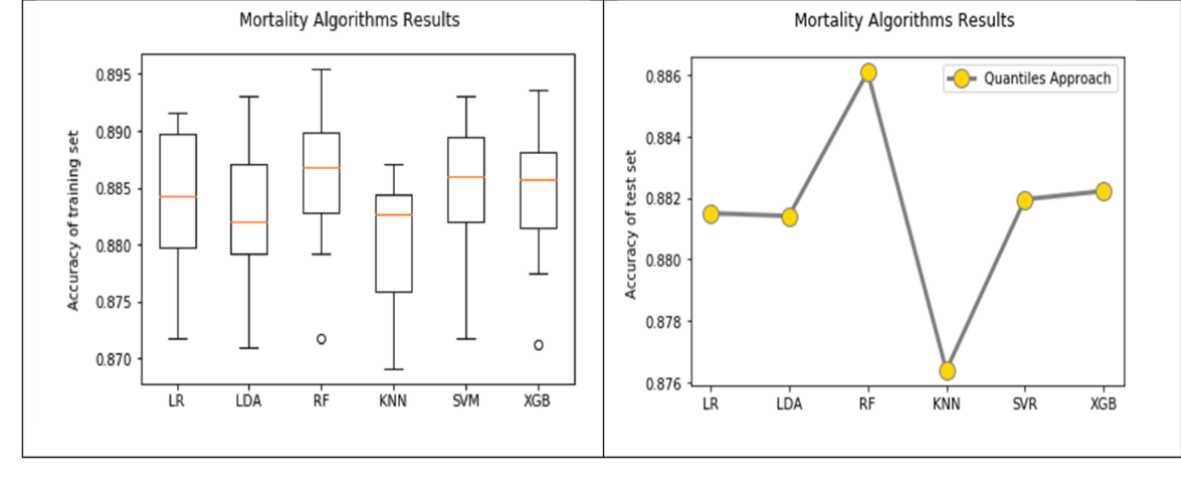
Figure 6. Comparison of the mortality model results using the quantiles approach on the training set (left) and the test set (right). LR: logistic regression;